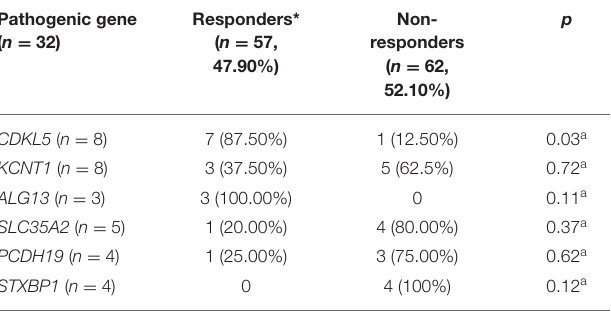
TABLE 3 | Responses to 16-week KD (3:1) treatment related to specific mutated gene, with the p -value for the comparison of the efficacy of KD in patients with each specific mutated gene to that of those patients without the mutation in that specific gene.